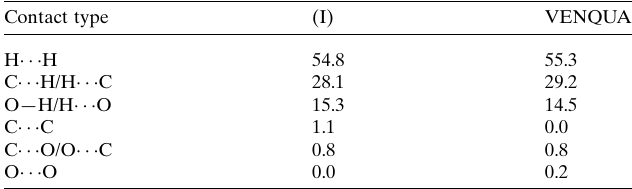
Table 6 Fingerprint contact percentages for (I) and VENQUA. Contact type